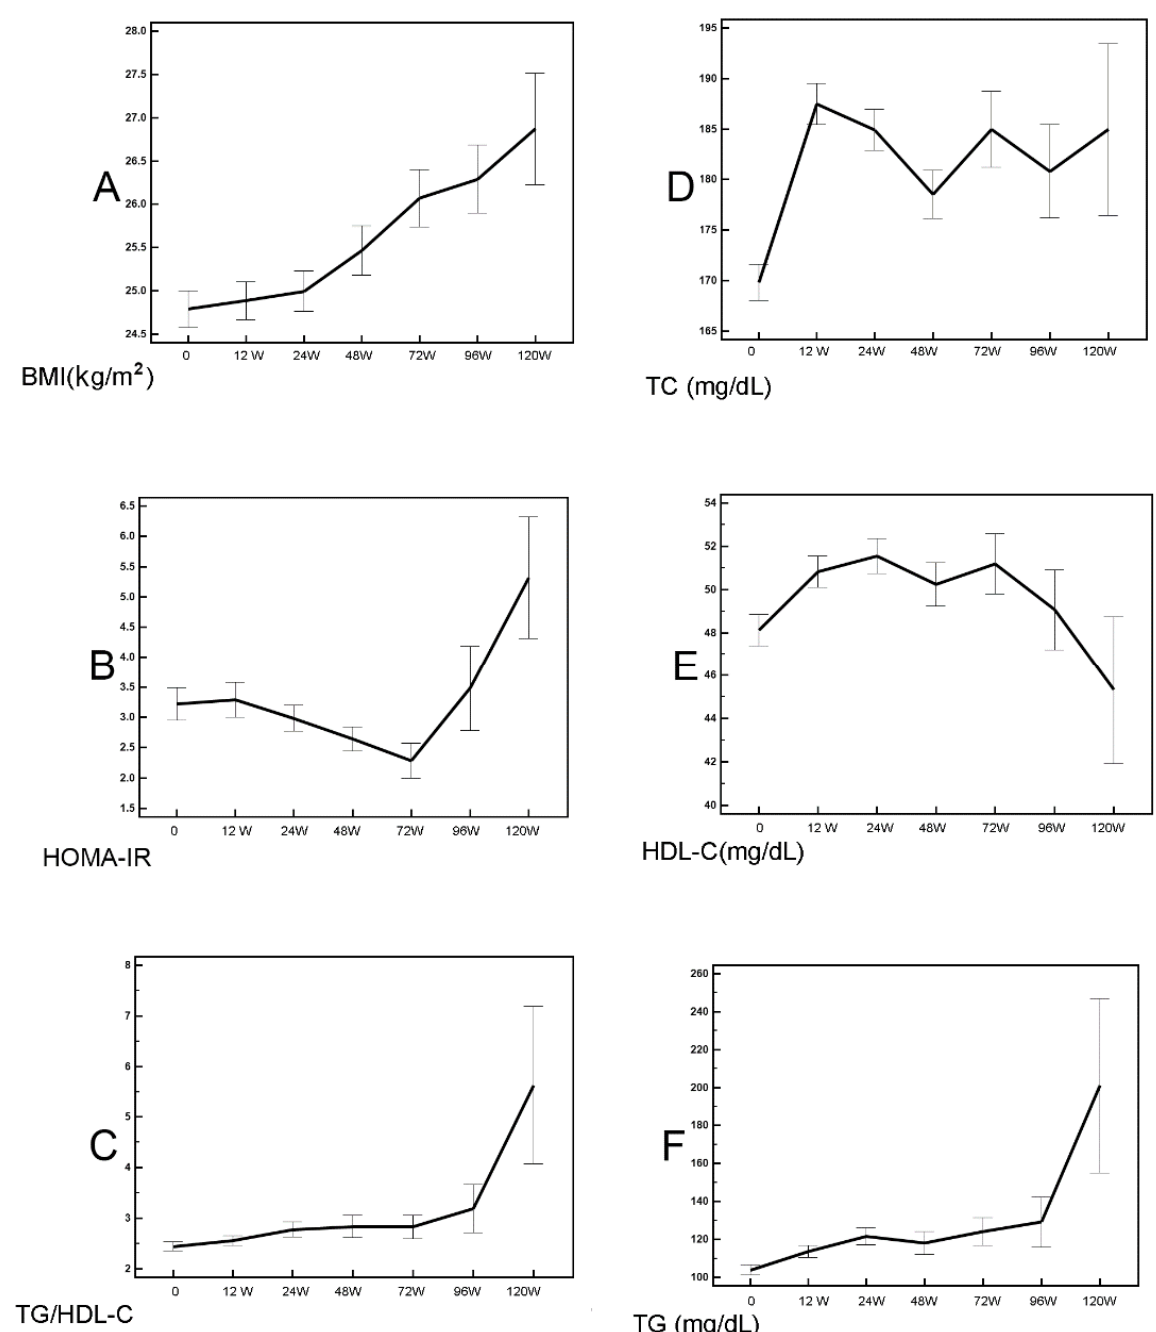
Figure 3. Longitudinal metabolic alteration of SVR patients. Mean ± standard error of body mass index (BMI) ( A ), homeostasis model assessment of insulin resistance (HOMA-IR) ( B ), triglycerides (TGs)/ high-density lipoprotein cholesterol (HDL-C) ratio ( C ), total cholesterol ( D ), HDL-C ( E ), and TGs ( F ). Time point: 0 represents baseline; W represents weeks after completion of anti-HCV therapy. The associated p values were showed in Table S5.